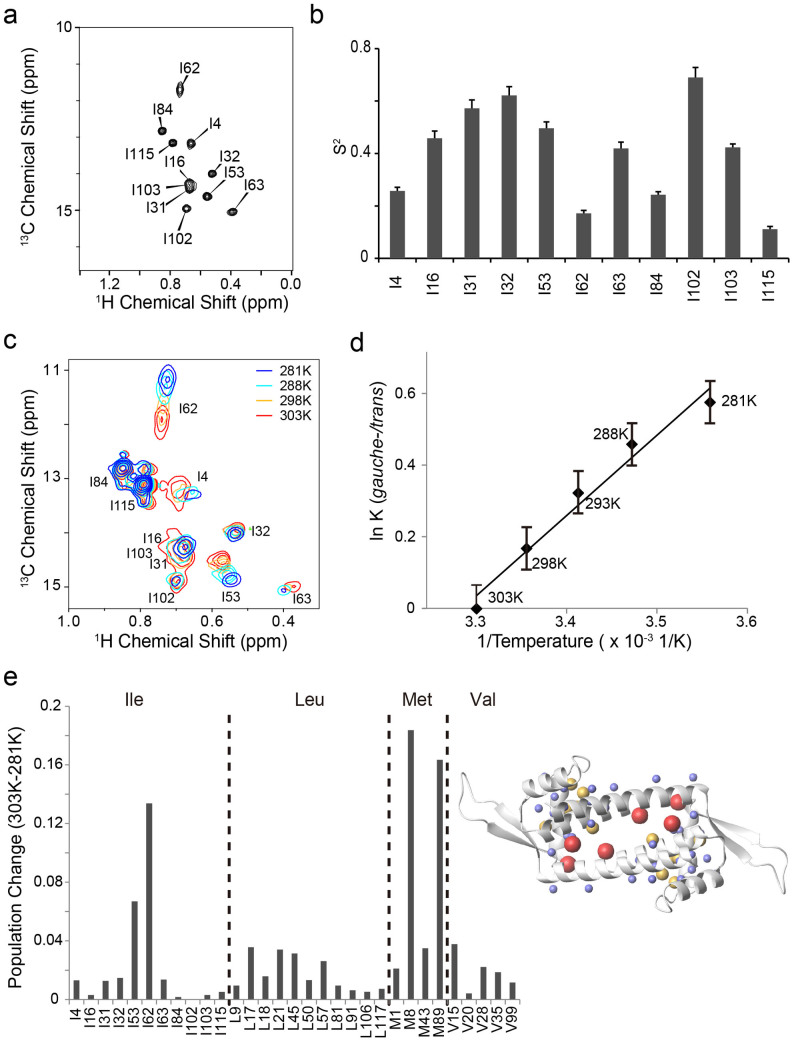
Conformational equilibrium in apo LmrR.(a), The Ile δ1 region of the 1H-13C HMQC spectra of LmrR in the apo state. (b), Methyl S2 values of Ile δ1. Error bars correspond to standard deviation (SD) of fitting errors. (c), Temperature dependence of the Ile δ1 resonances of apo LmrR. (d), The van 't Hoff plot for the Ile-62 χ2 angle rotational equilibrium in the apo state. The error bars correspond to the acquisition resolution of indirect 13C dimension. e, Temperature-dependent population change in Ile χ2, Leu χ2, Met χ3, and Val χ1 rotameric states between 281K and 303K. Right: the methyl moieties with more than 10% or 3% rotameric population shift in response to the temperature variation are highlighted in red and yellow, respectively. The methyl moieties that did not show more than 3% rotameric population shift were depicted by small blue spheres.